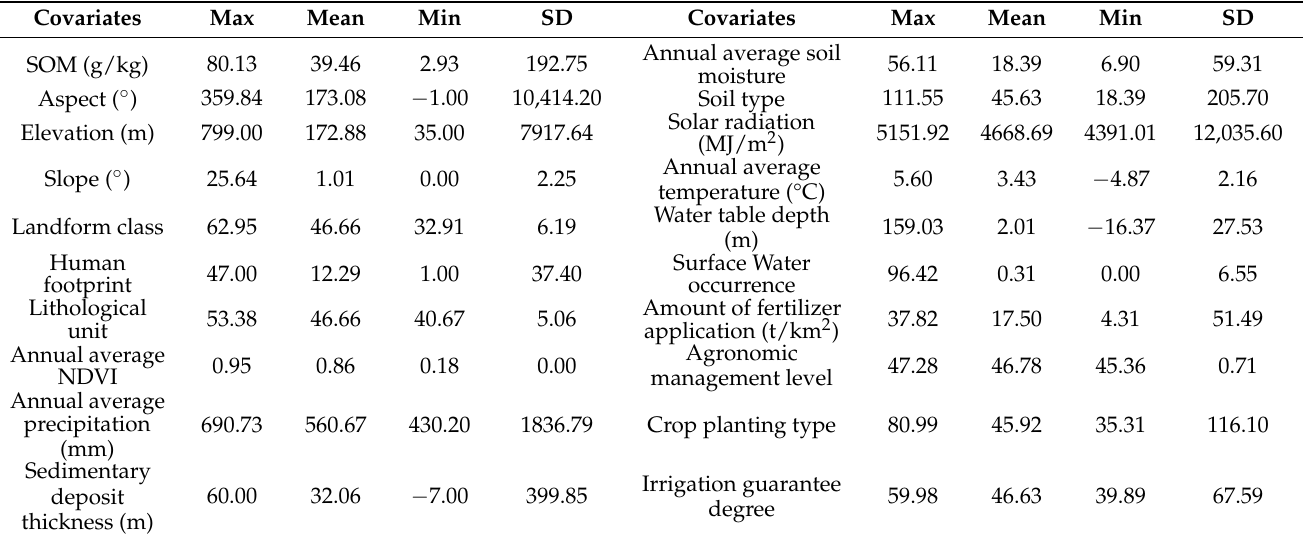
Figure 3. Partial correlation analysis between 19 covariates (the partial correlation coefficients range from − 0.48 with blue to 0.56 with red). Table 3. Summary statistics of SOM and quantitative covariates of all